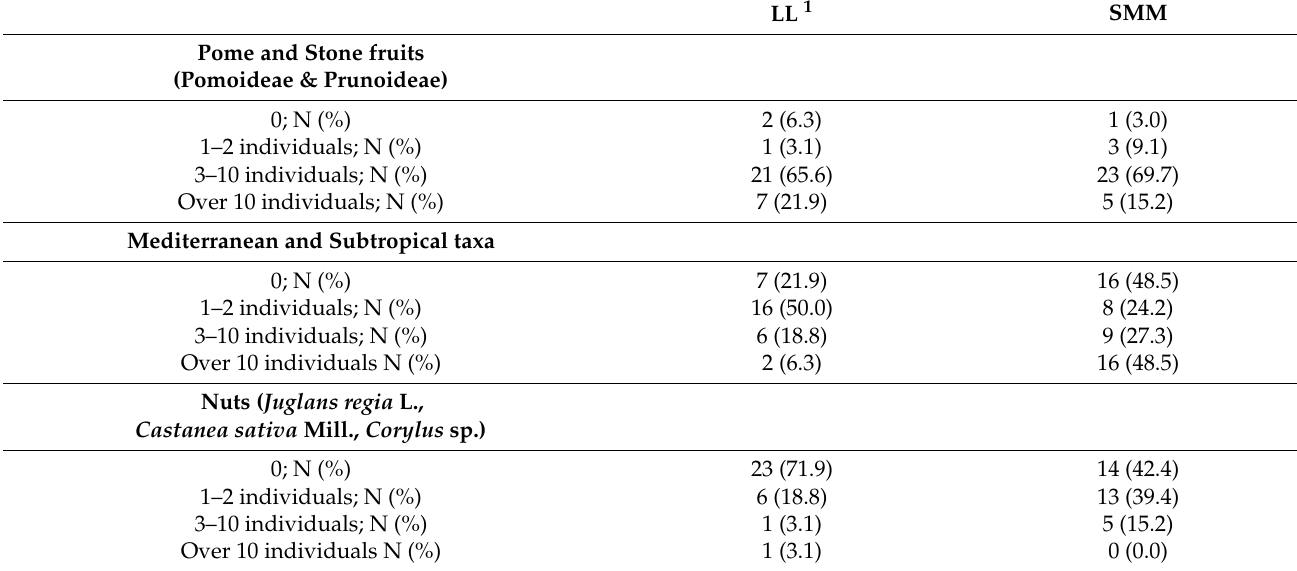
Table 4. Occurrence of trees, shrubs and vines cultivated in rural home gardens. LL 1